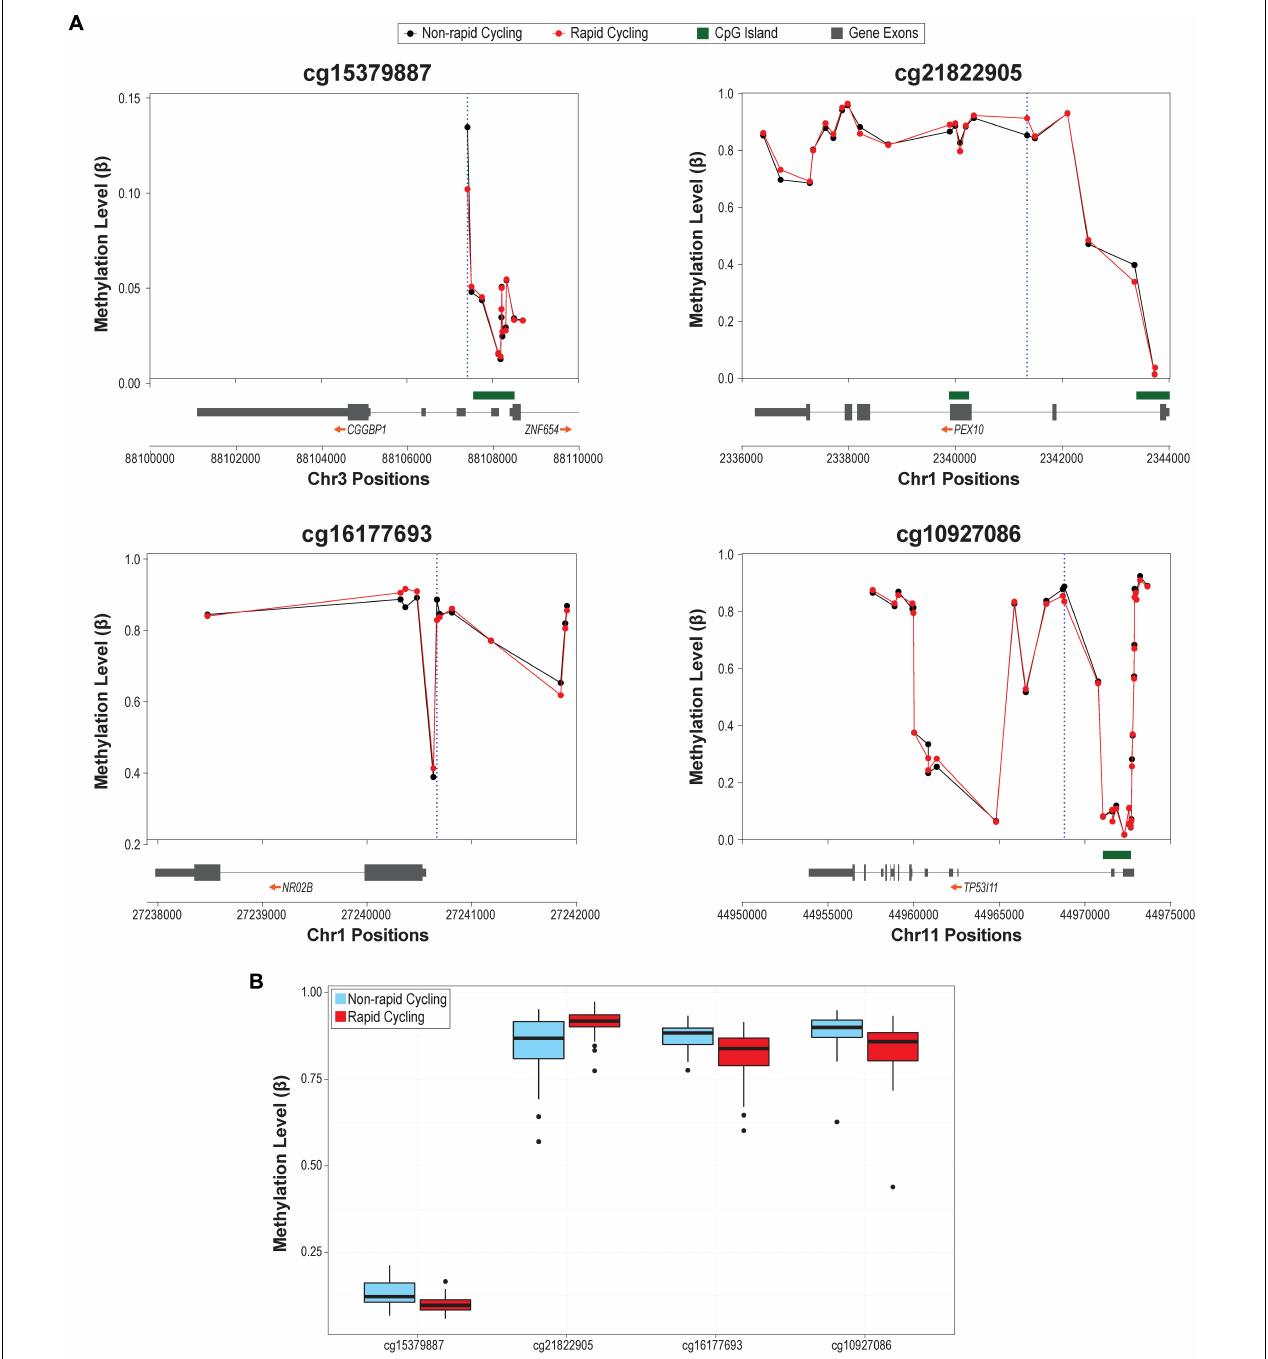
FIGURE 2 | (A) Regional plots of the top differentially methylated probes (DMPs; p < 1E-05). Blue dotted vertical lines mark the genomic locations of the most significantly differentially methylated CpGs in that region. (B) Box plots of the methylation levels of the four DMPs differed between rapid cyclers and non-rapid cyclers at p <